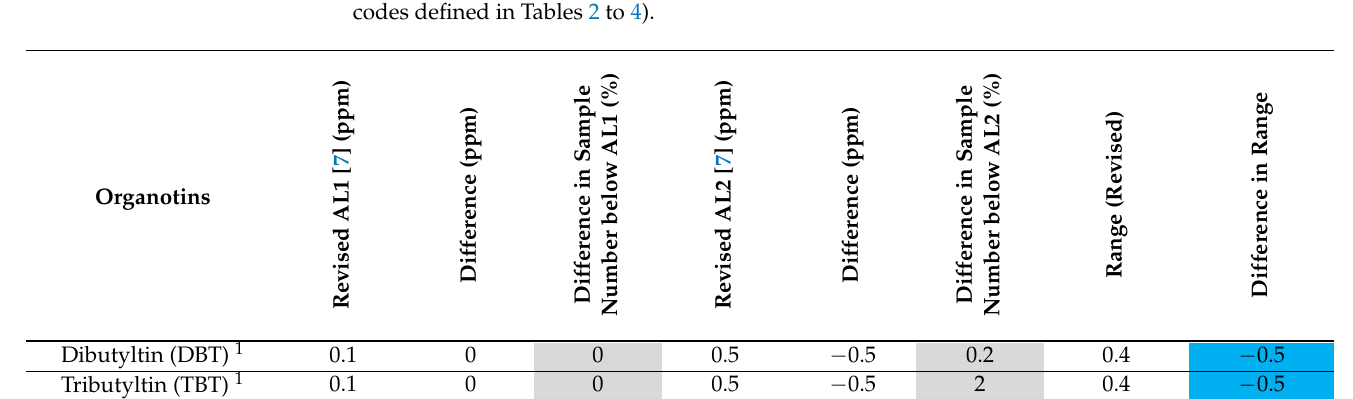
Table 8. Organotins (DBT, dibutyltin; TBT, tributyltin)—Difference (revised − current) in the percent- age of samples below AL1; above AL2 for revised ALs and the range of values between AL1 and AL2. Please note values (green) are more protective and values (orange) are more permissive (colour codes defined in Tables 2 to